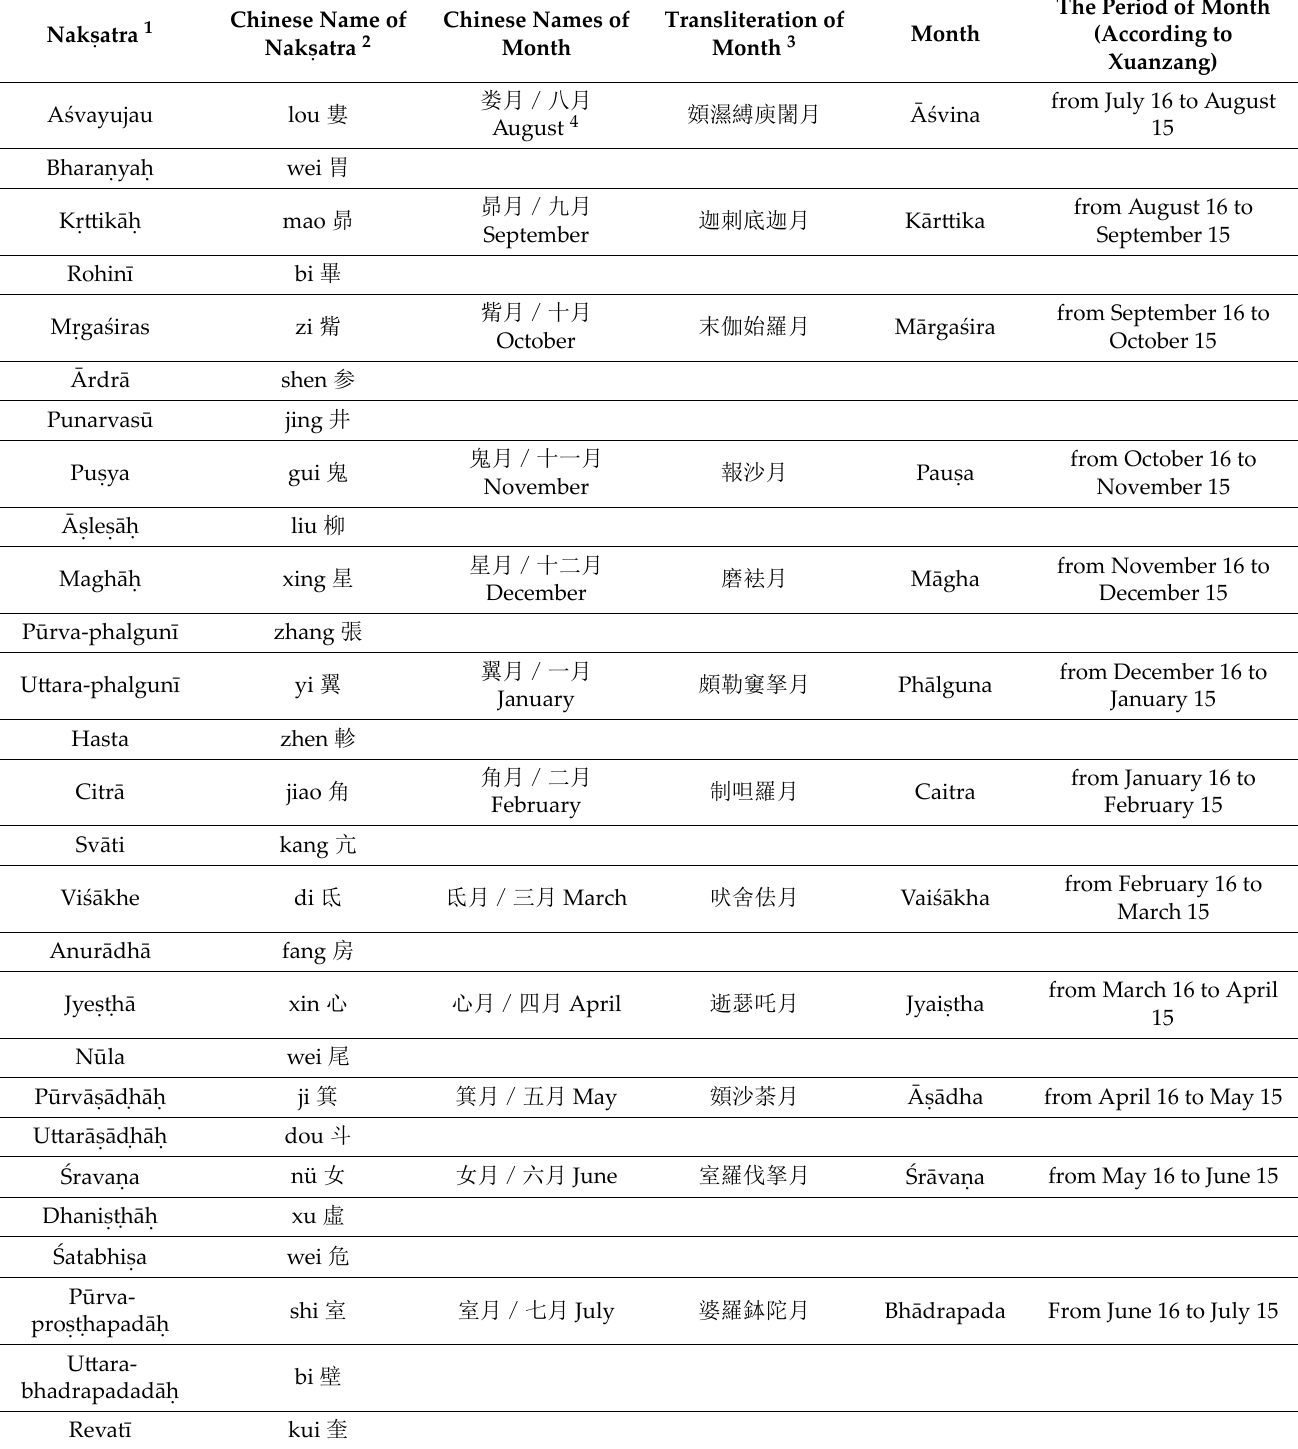
atra and months according to Xuanzang 玄奘 ˙